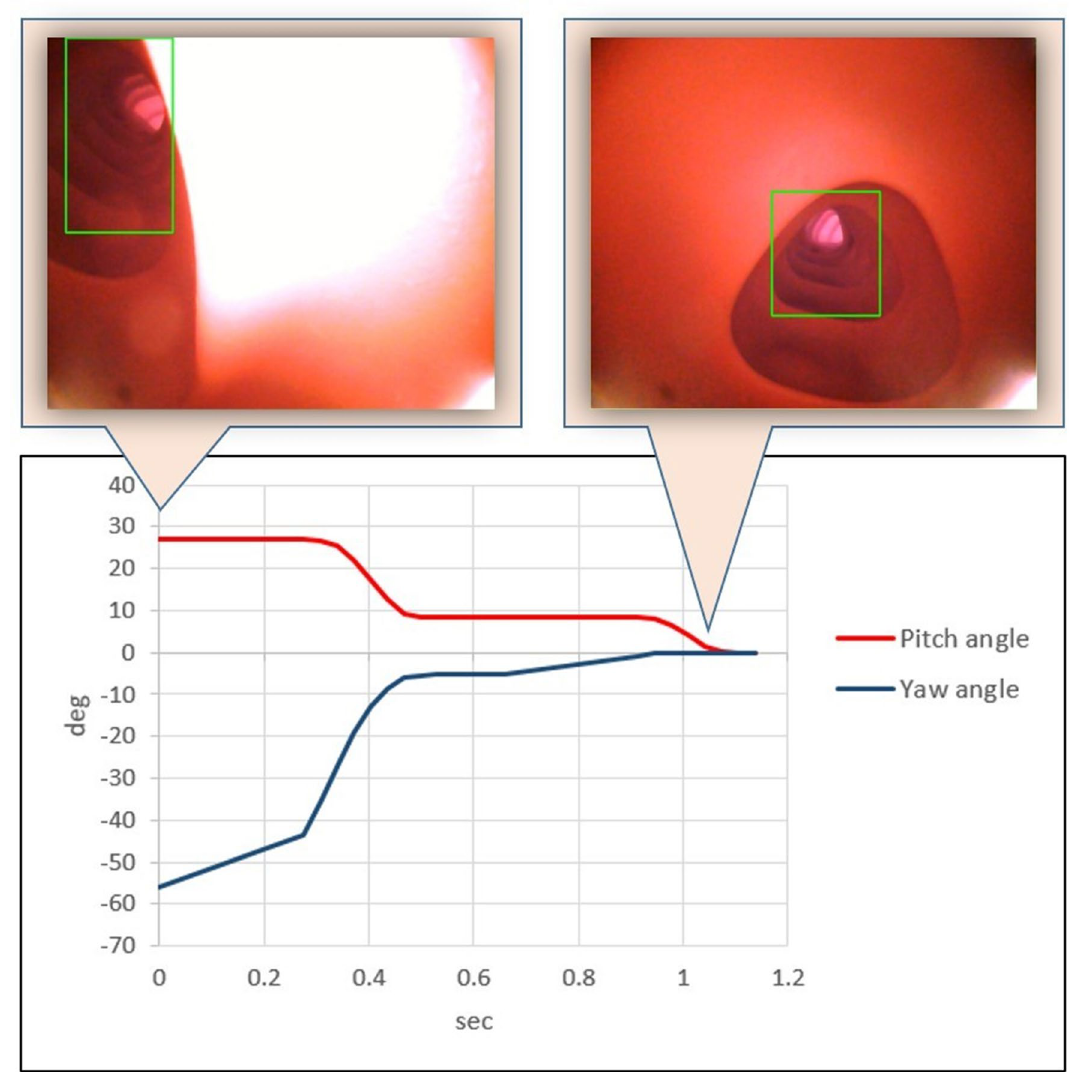
Figure 2. Record of the MCC rotated by angles of yaw and pitch. The position of the lumen was initially located in the northwest area of the image. The MFN completed the alignment in 1.14 s with the PI control. deg, adjustment of yaw and pitch in degrees; sec, time required to adjust the angle in seconds.